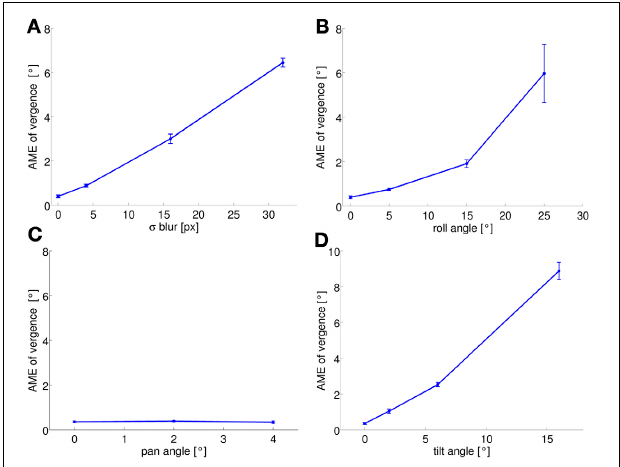
FIGURE 4 | AME of vergence at the end of training is plotted as a function of the level of each perturbation (average over 5 simulation runs): (A) blur; (B) roll; (C) pan; (D) tilt. AME increases with the level of a perturbation for all types of perturbation, except the pan perturbation (see text). Error bars represent one standard deviation.